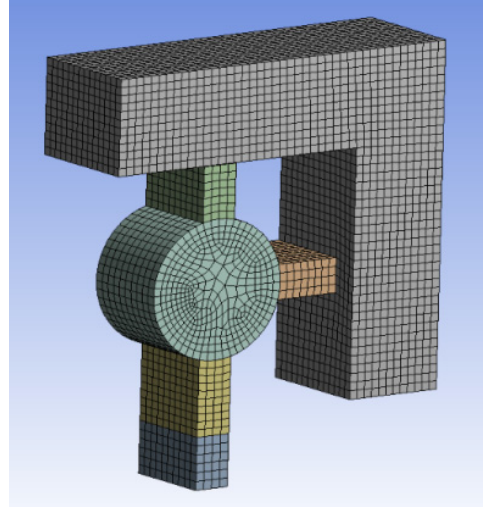
Figure 6. Finite element model.